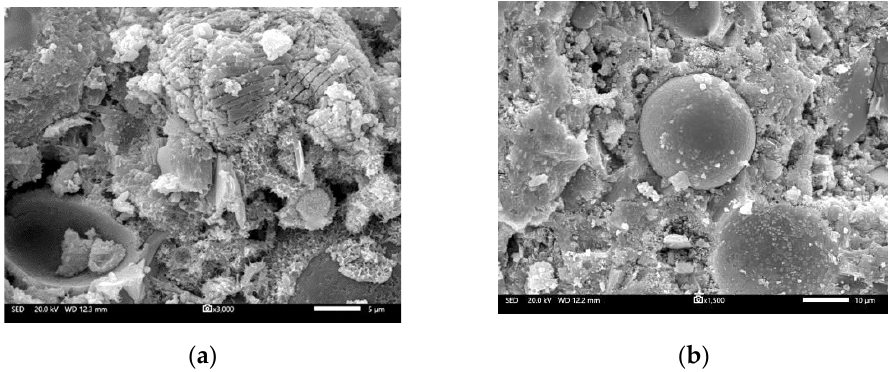
Figure 11. SEM pictures of FA25-P under the FC1 condition, ( a ) Microstructure and ( b ) FA particles in paste.